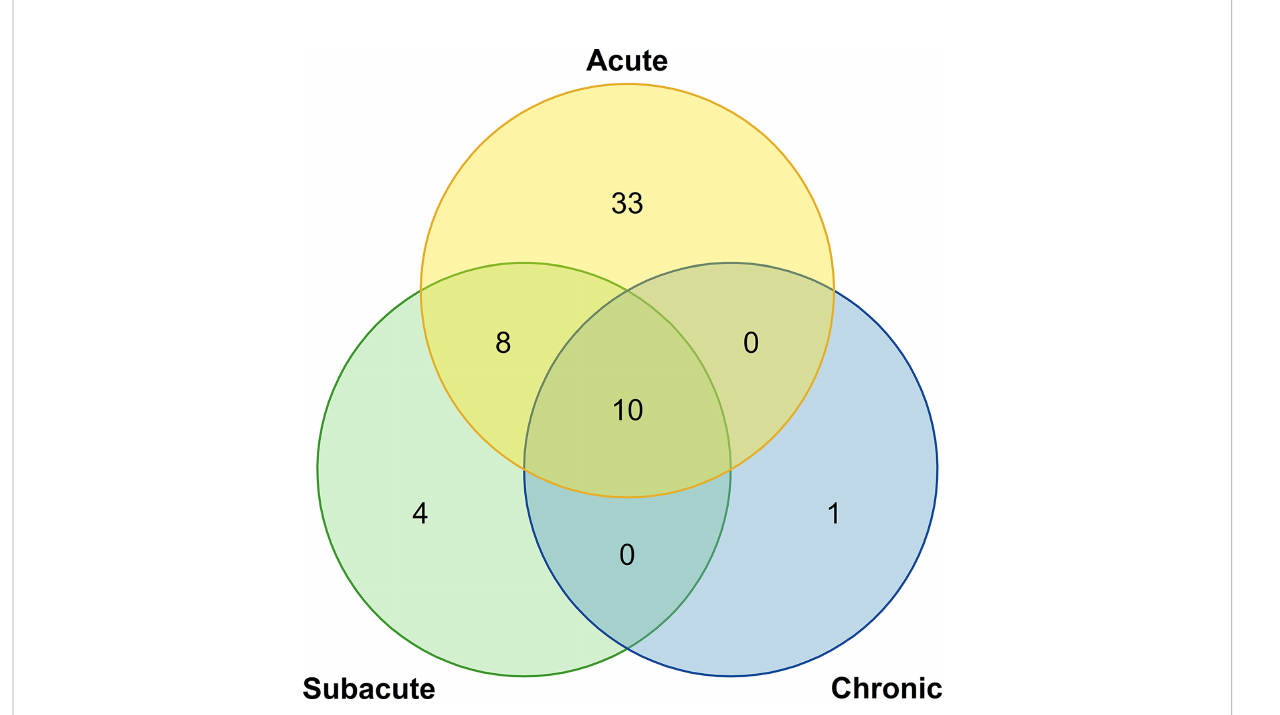
FIGURE 1 The Venn diagram of the numbers of patients in acute, subacute, and chronic